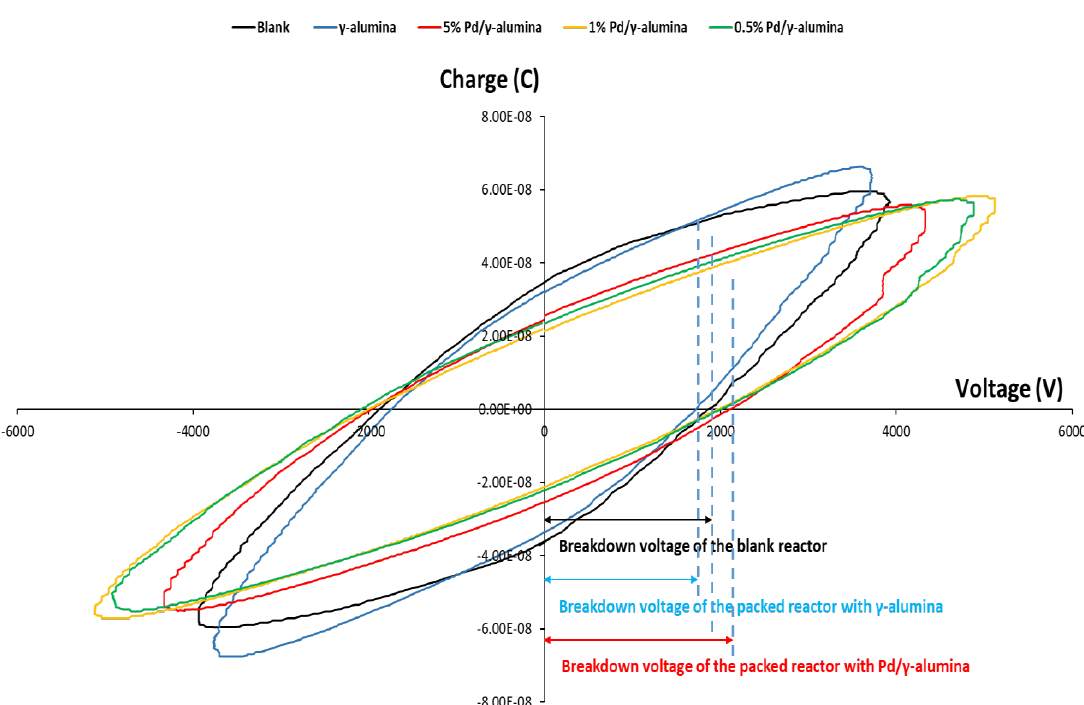
Figure 1. E ff ect of the catalyst on Lissajous Figure 1. Effect of the catalyst on Lissajous figures. 92